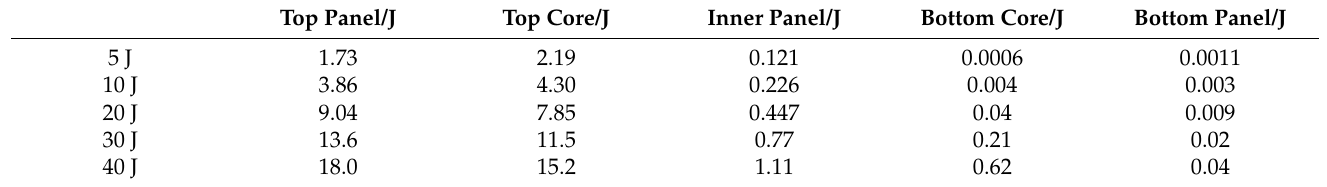
Table 7. Energy absorption of each component of double-layer structure with different impact energies. Top Panel/J Top Core/J Inner Panel/J Bottom Core/J Bottom